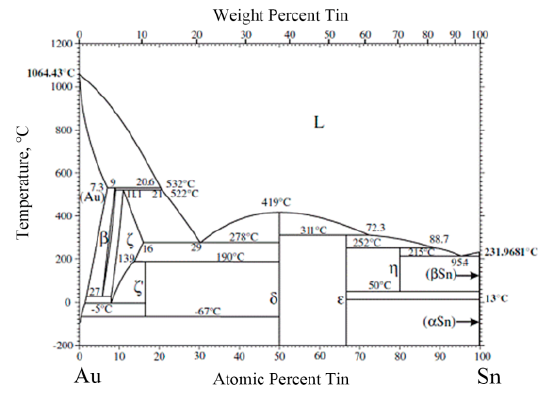
Figure 4. Au-Sn phase diagram [22].